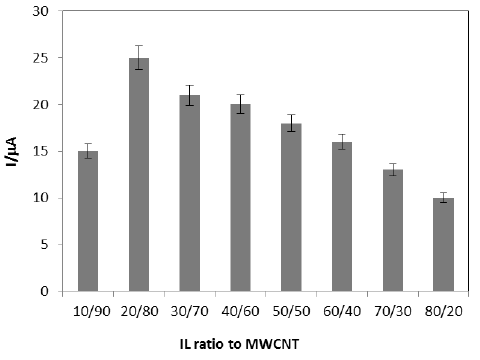
Figure 4. The current comparsion obtained from the cyclic voltammograms for phosphate buffer 0.05M pH7.0 and 4mM of Fe(CN) 6-3/-4 using IL/MWCNT paste electrode in different ratio. Scan rate of voltammogram for this diagram was 50